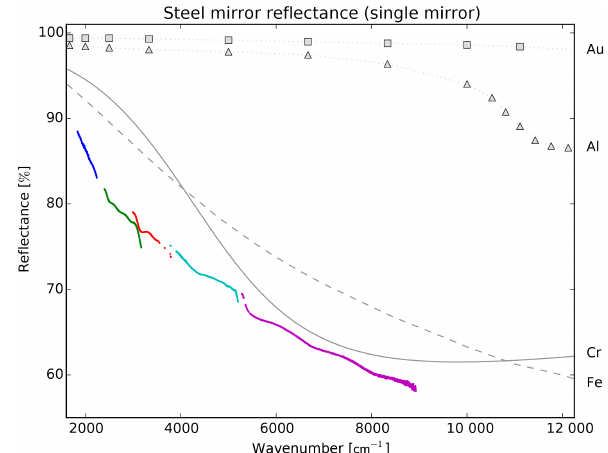
Figure 9. Measurements of the steel mirrors’ reflectance R , nor- malised for a single-mirror reflection (coloured lines). The different colours correspond to different optical filters that were used. Spec- tral windows with significant absorption from H 2 O and CO 2 were blanked out. Measured reflectance values for Au and Al as well as modelled values for Cr and Fe are shown for